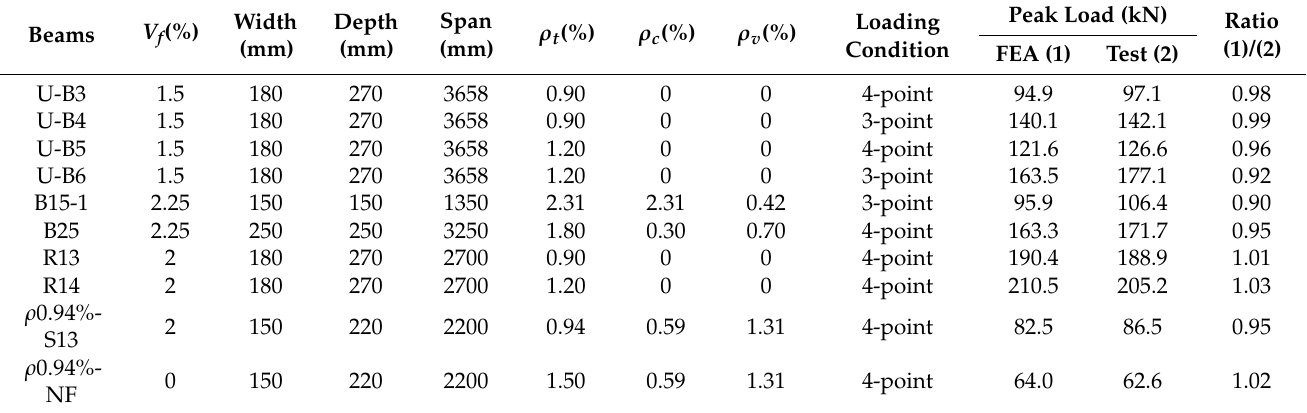
Table 1. Details of the beams used for validation and comparison of load carrying capacity of UHPC beams as predicted by FEA with test data.